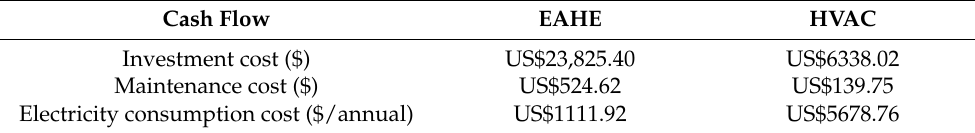
Table 2. EAHE vs. HVAC